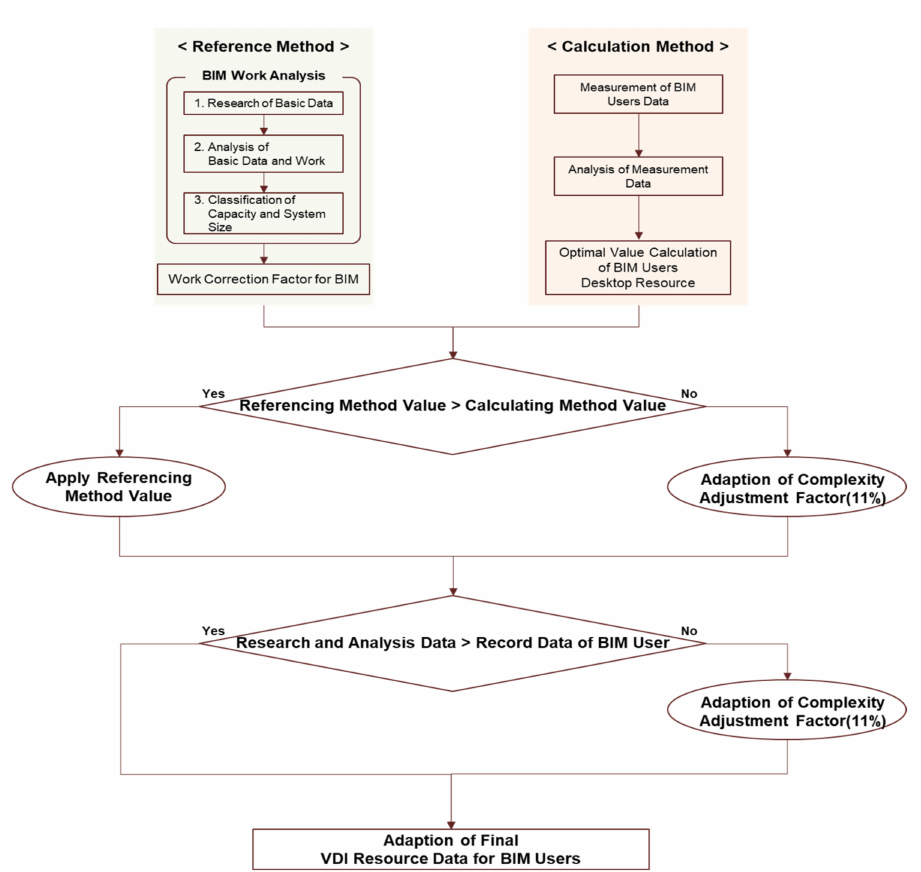
Figure 4. VDI server sizing algorithm in BIM environment.